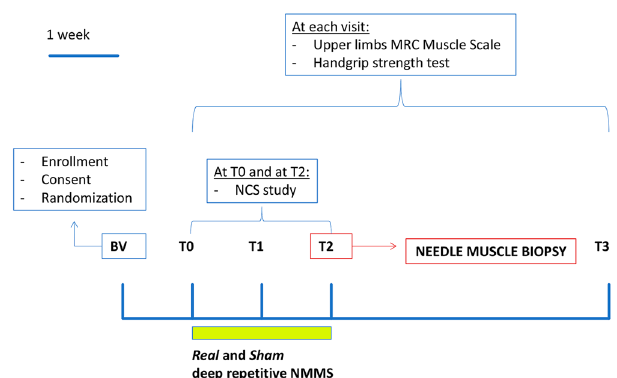
Figure 1. Study design. BV (baseline visit) represents the screening of ALS patients; T0 is the first recording of clinical strength and neurophysiological parameters before stimulation, T1 after one week, and T2 after two weeks of stimulation; T3 is thirty days after the end of